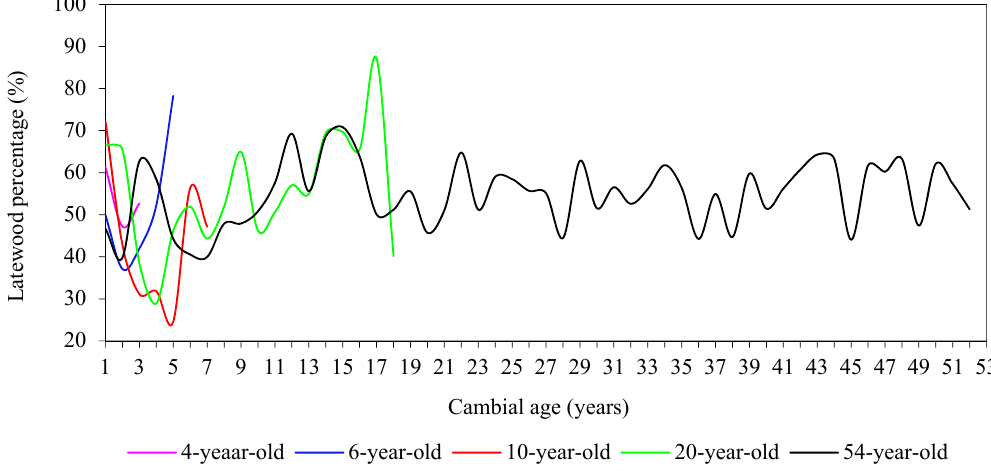
Figure 6. The radial variation of annual latewood percentage versus cambial age in S. superba.